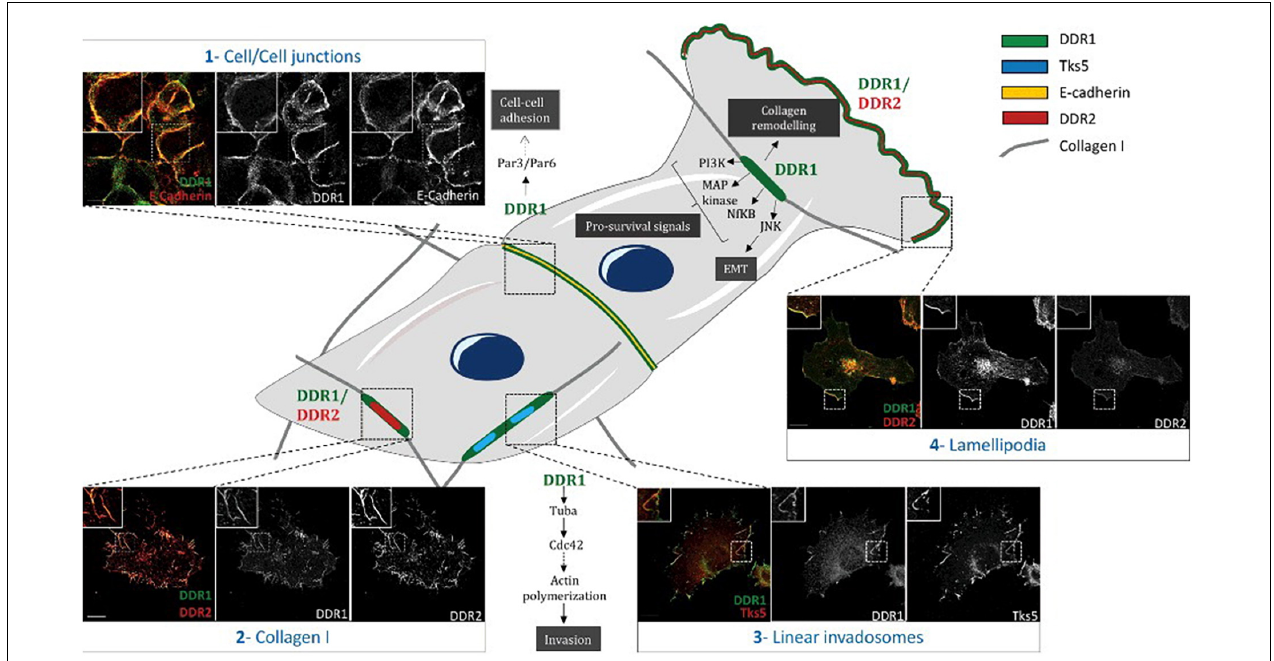
FIGURE 4 | Differential subcellular localization of DDRs in cells. Schematic representation illustrating different subcellular localizations of DDRs in cells associated with their functions. (1) In A431 cells, DDR1 interacts with E- cadherin and the polarity complex Par3/Par6 in order to maintain cell/cell junctions. (2) In A375 cells, DDR1 and DDR2 colocalize together with fibrillar collagen type I. (3) In A375 melanoma cells, on a collagen I matrix, DDR1 co-localizes with Tks5 (a marker of invadosomes). DDR1 activation induces Tuba/Cdc42 pathway leading to linear invadosome formation. (4) In A375 melanoma migrating cells, both DDR1 and DDR2 co-localize with lamellipodia. Some pathways induced by DDR1 activation are represented in this schematic. Scale bar = 5 mM. Reprinted from Henriet et al. (2018).